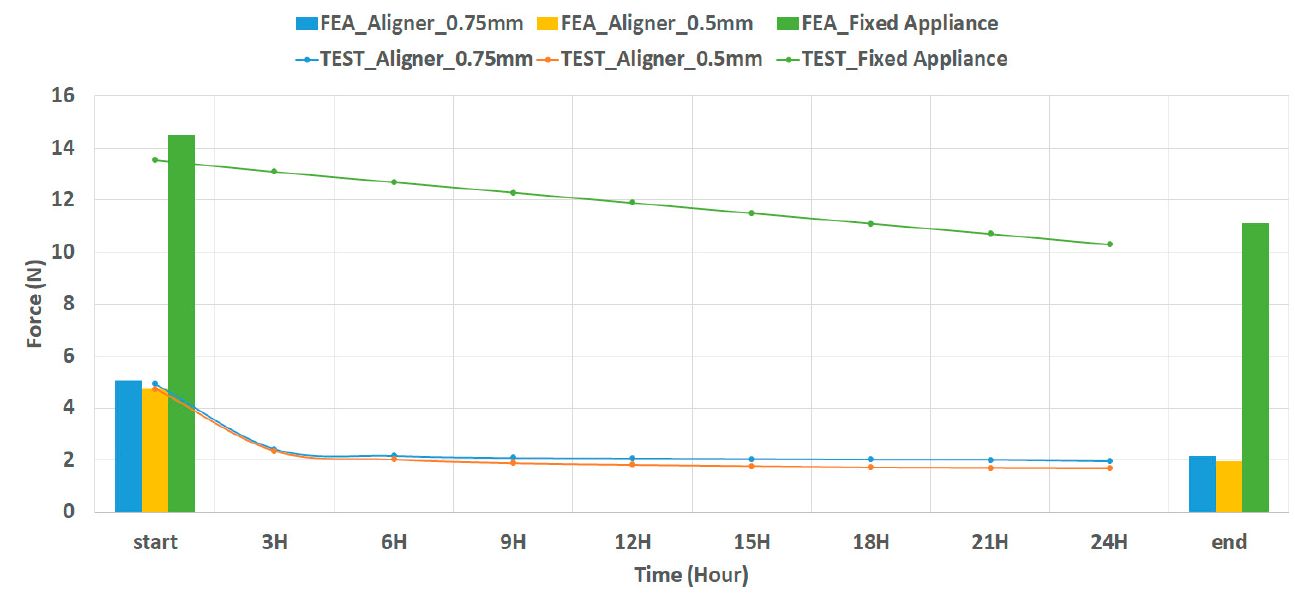
Figure 13. Comparison of the results of loading condition verification analysis and in vitro orthodontic force measurement.